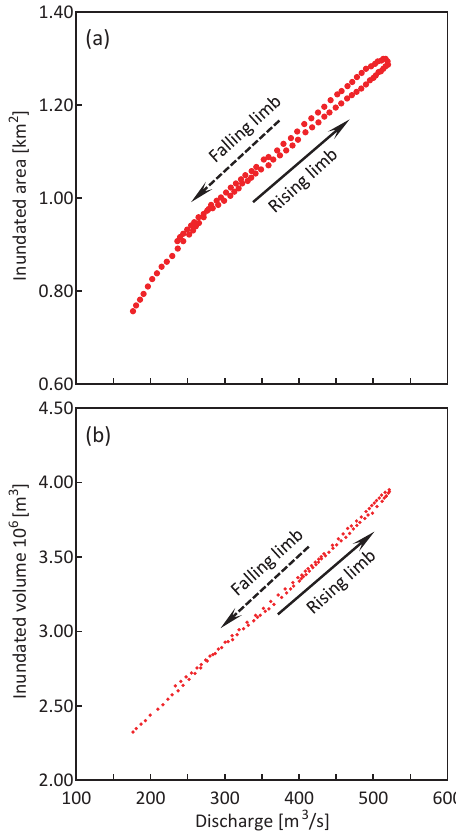
Figure 11. The scatter plots of inundation area versus discharge (a) and inundated volume versus discharge (b) of a sample flood